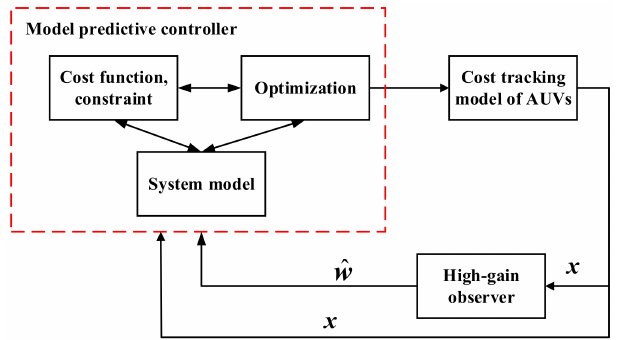
Figure 4. Nonlinear model predictive control system with disturbance observer (Reprinted from Reference [39] with permission from IJMS, copyright